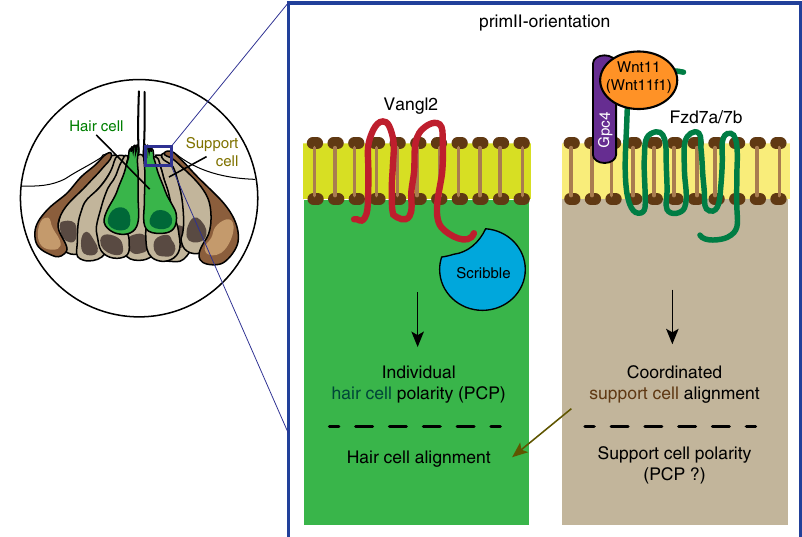
Fig. 7 The PCP and Wnt pathways act in parallel to establish coordinated hair cell polarity and orientation in the neuromast. Model of how the PCP signaling genes Vangl2 and Scrib are required to establish individual polarity in the hair cells (left part of the box), while the Wnt pathway members Wnt11 (Wnt11f1), Gpc4 and Fzd7a/7b interact to establish coordinated support cell alignment (right part of the box) in primII-derived neuromasts. The coordinated alignment of support cells, which we assume have normal polarity because coordinated alignment is not disrupted in PCP signaling mutants, then dictates the individual hair cell